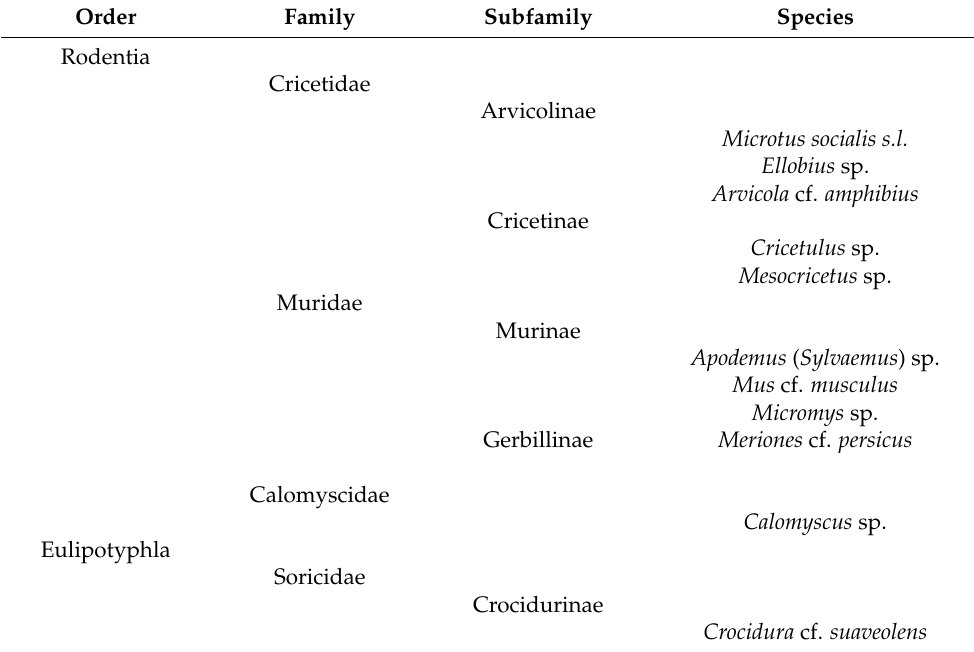
Table 1. Preliminary microvertebrate faunal list from Shanidar